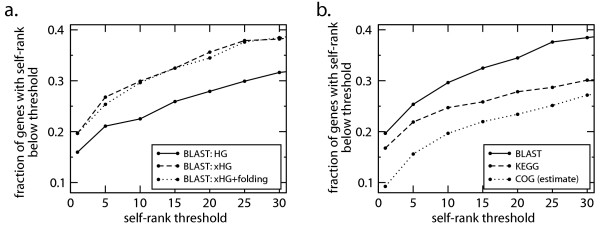
Performance of different phylogenetic profile datasets and corrections. The predictive performance of the algorithm is illustrated by showing the fraction of known enzyme-encoding genes (x axis) predicted within different self-rank thresholds (y axis). For instance, dashed performance curve in subfigure a. (BLAST:xHG) shows that 30% of the test enzymes appear within the top 10 (out of 3352) candidates for their enzymatic function. a. Algorithm performance in predicting known E. coli metabolic enzymes based on the phylogenetic profile associations with the 1st layer of the metabolic network neighborhood. Performance of a regular hypergeometric distribution is shown (HG), together with extended hypergeometric (xHG) and folding (xHG+folding) corrections. The scores are calculated on the BLAST-based dataset. b. The self-rank performance of the 1st layer phylogenetic profile score, calculated using extended hypergeometric distribution with folding is shown for BLAST-based, KEGG-based and COG orthology datasets. The performance of the COG orthology dataset is corrected for the metabolic gene coverage bias.